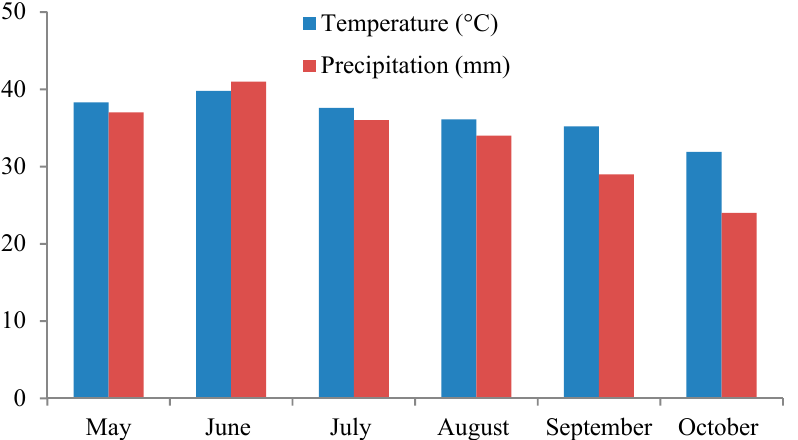
Figure 1. The meteorological features (temperature and precipitation) of experimental site (Faisala- bad, Punjab, Pakistan) during crop growing seasons, (2 years mean data).